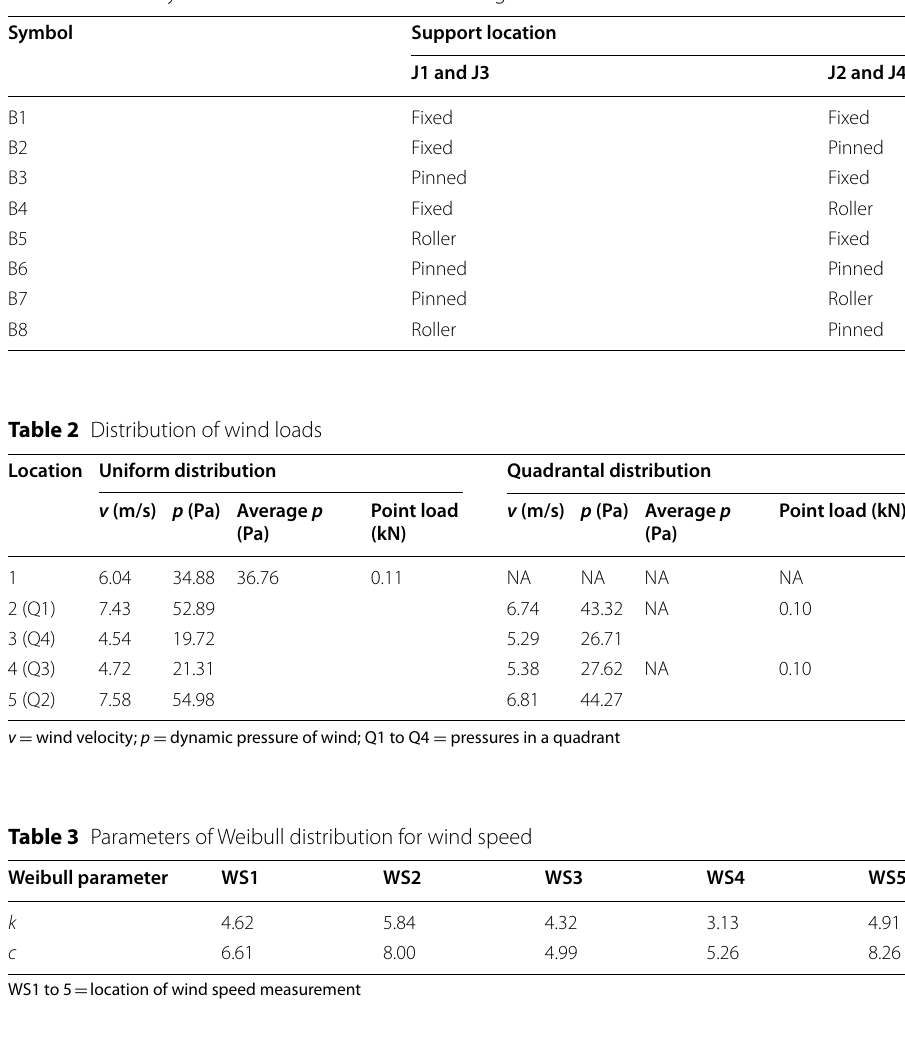
WS1 to 5 location of wind speed =